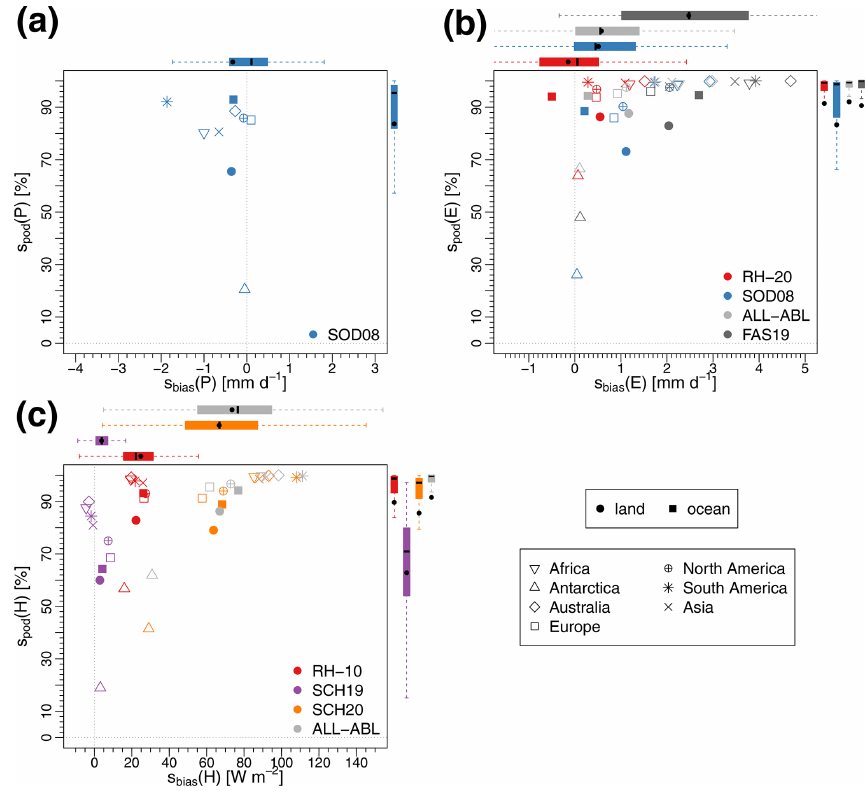
Figure 4. Bias ( s bias ) and probability of detection ( s pod ) of daily (a) precipitation, (b) surface evaporation, and (c) surface sensible heat flux averaged over continents (indicated by different symbols), all land, and ocean pixels for the period 1980–2016. Colors indicate different diagnosis criteria. The box plots show the average distribution over all pixels globally (the back line shows the median; boxes show the 25% and 75% percentiles; dashed lines show 1.5 the interquartile range); black points in the box plots indicate the average.